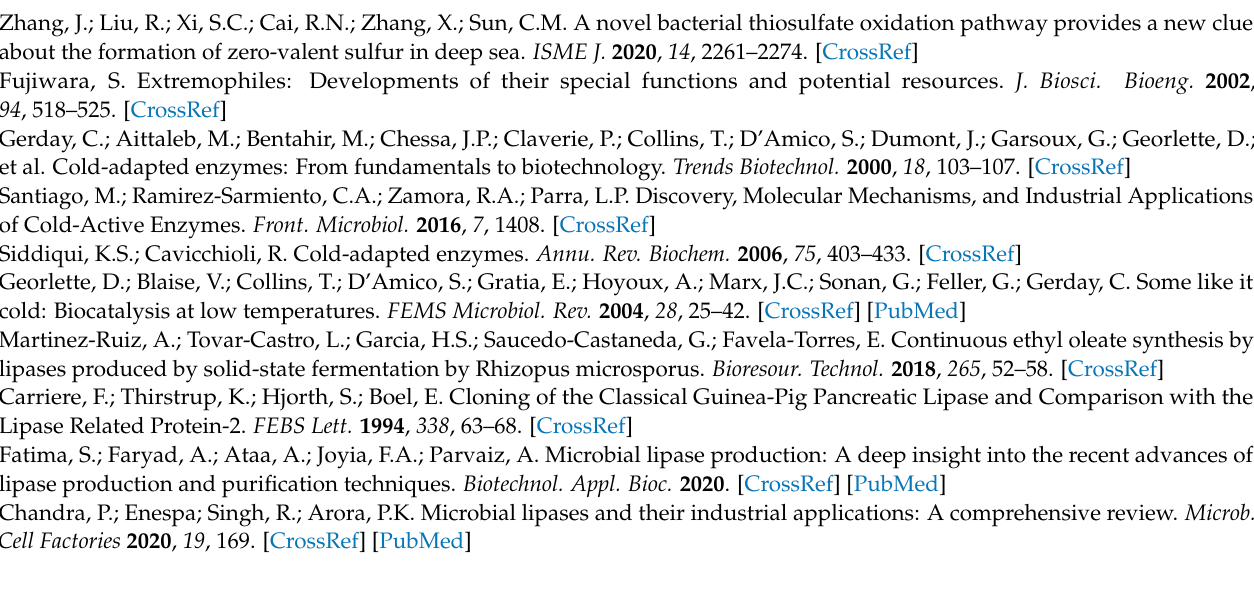
related taxa. The sequence of Chromatocurvus halotolerans EG19 T was used as an outgroup. Bootstrap values at nodes were derived from 1000 replicates. Only bootstrap values higher than 50% are shown. Bar, 0.02 substitutions per nucleotide position, Figure S4: Minimum-evolution tree based on 16S rRNA gene sequences of strain gcc21 and related taxa. The sequence of Chromatocurvus halotolerans EG19 T was used as an outgroup. Bootstrap values at nodes were derived from 1000 replicates. Only bootstrap values higher than 50% are shown. Bar, 0.01 substitutions per nucleotide position, Table S1: Comparison of the main fatty acids (%) of strain gcc21 and type strains P. aeruginosa DSM50071 T , Table S2: ANIb, ANIm and is DDH values between the genome sequence of strain gcc21 and closely related Pseudomonas species, Table S3: Amino acid composition of Lipase 1 and Lipase